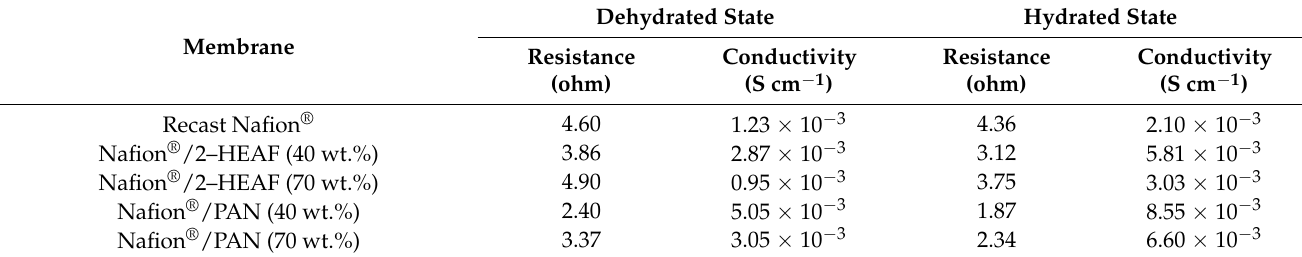
Table 3. Proton conductivity and resistance for all membranes in dehydrated and hydrated states. Dehydrated State Hydrated State Membrane Resistance Conductivity Resistance Conductivity (ohm) (S cm − 1 ) (ohm) (S cm − 1 ) Recast Nafion ® 4.60 1.23 × 10 − 3 4.36 2.10 × 10 − 3 Nafion ® /2–HEAF (40 wt.%) 3.86 2.87 × 10 − 3 5.81 × 10 − 3 Nafion ® /2–HEAF (70 wt.%) 0.95 × 10 −